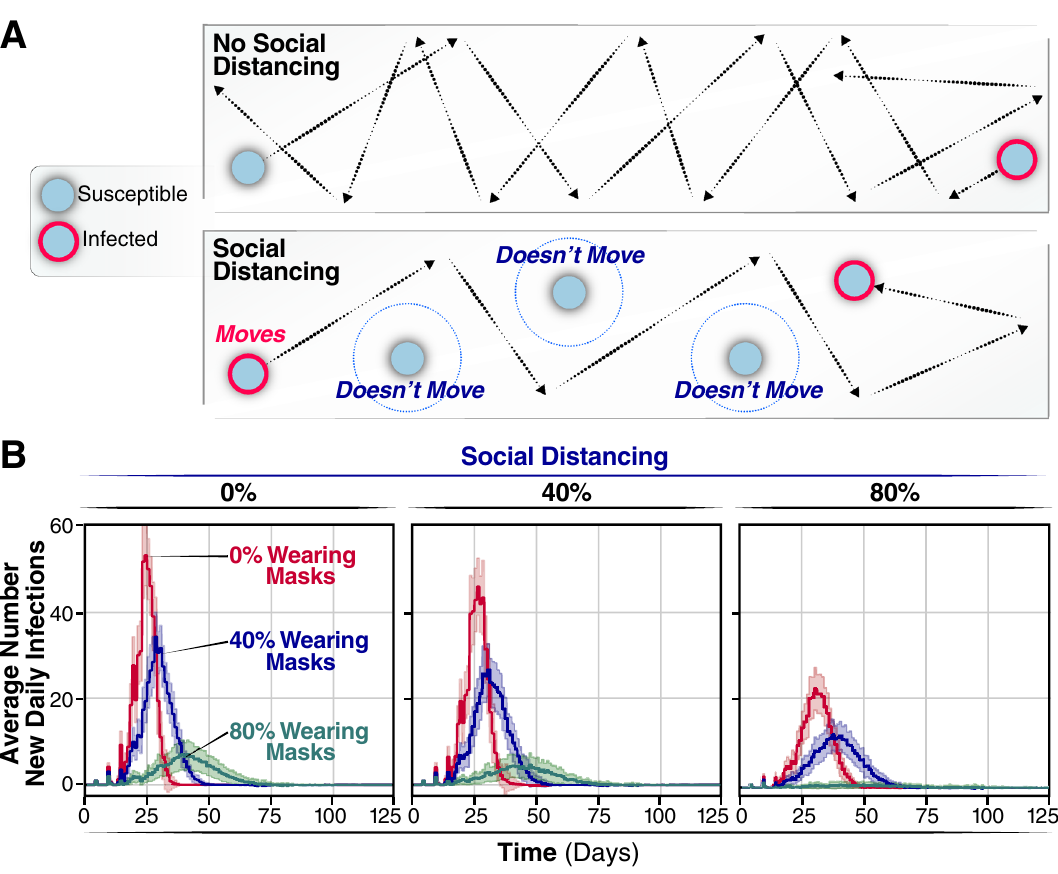
Figure 2. Average new infections per day when varying the population wearing masks and practicing social distancing. ( A ) SD is implemented by assigning agents to not move along a trajectory during the simulation. This lack of movement reduces the number of trajectories overlaps between agents and subsequently reduces the number of transmission events. ( B ) The number of new infections per day for 0, 40, or 80% of a population wearing face-masks are displayed by red, blue, or green trajectories, respectively, for 0% of the population practicing SD, for the 40% and for the 80%. Simulations were repeated 100 times for each condition, the curves and the highlighted regions around the curves represent the mean value + /- one standard